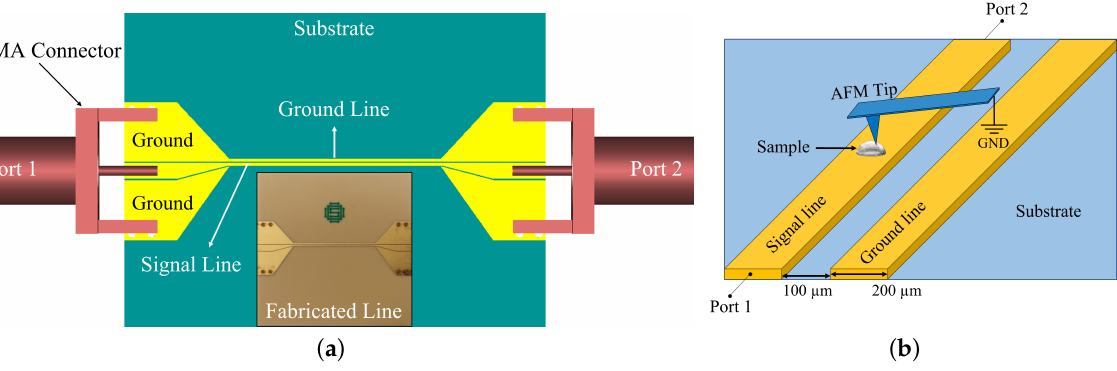
Figure 1. The experimental setup of the inverted SMM: ( a ) The slot-line design (inset shows the fabricated slot line). ( b ) Schematic description of the grounded metallic AFM tip and the slot line as a sample